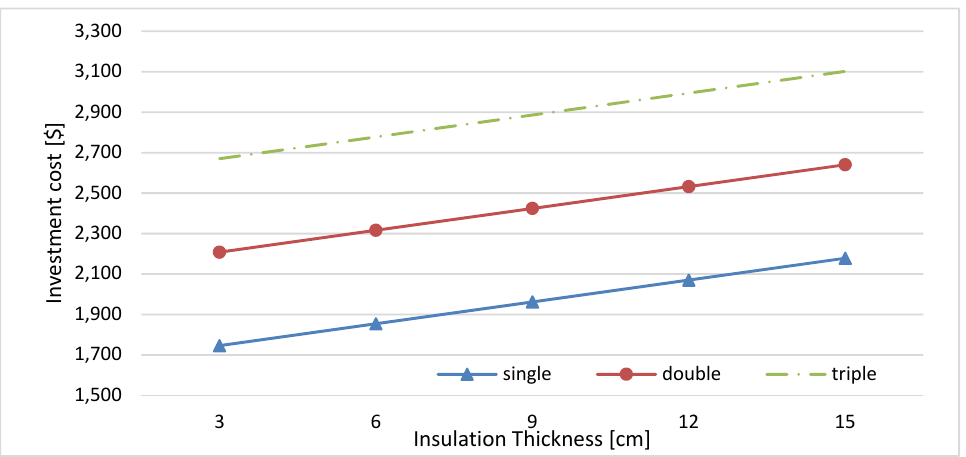
Figure 12. Effect of insulation thickness and window type on the insulation cost of the façade.